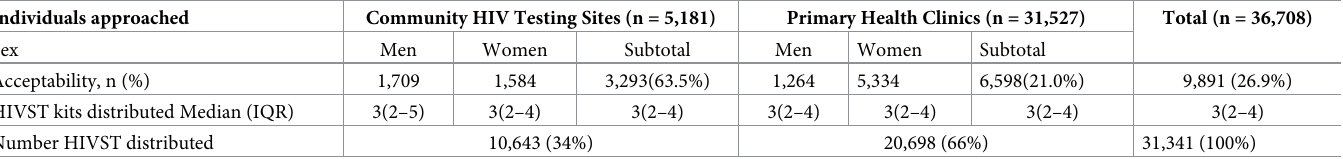
Table 1. Acceptability of HIV Self-test at study